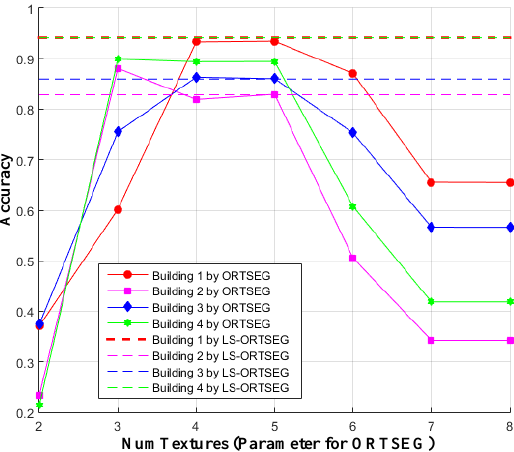
Figure 13. Accuracy using different texture numbers. The ‘Hist.wSize’ are set to 5, and ‘NumTextures’ are set from 2 to 8 for both ORTSEG and LS-ORTSEG.